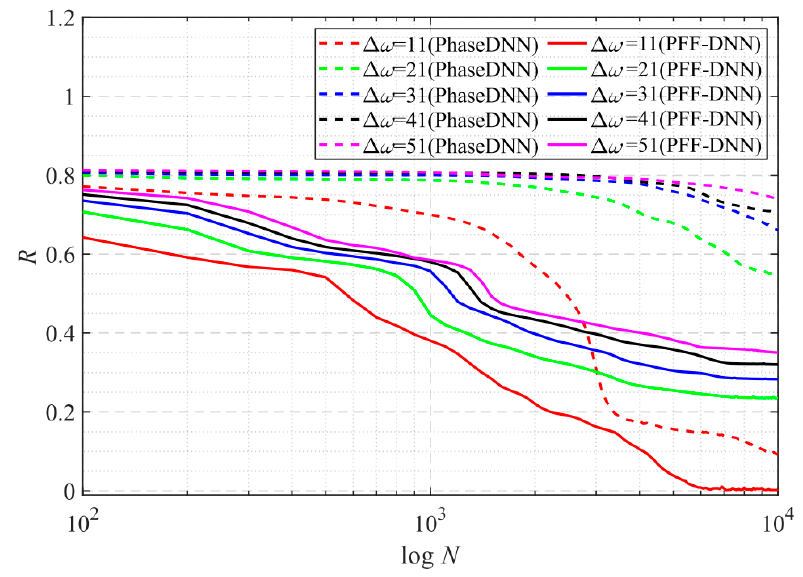
Figure 15. The influence of Δ ω on the convergence process.